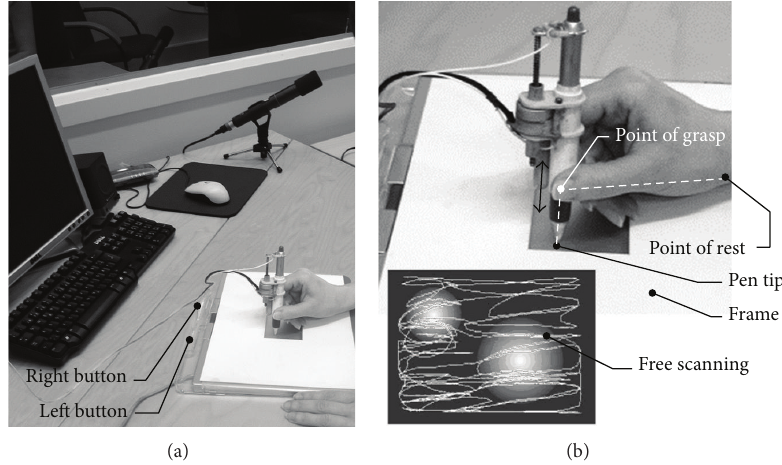
Figure 2: Experimental setup (on the left) and the schematic diagram specifying the reference points of the StickGrip grasp at exploration of the virtual surface (on the right). Virtual surface (on the bottom right), as viewed on the monitor of the experimenter.